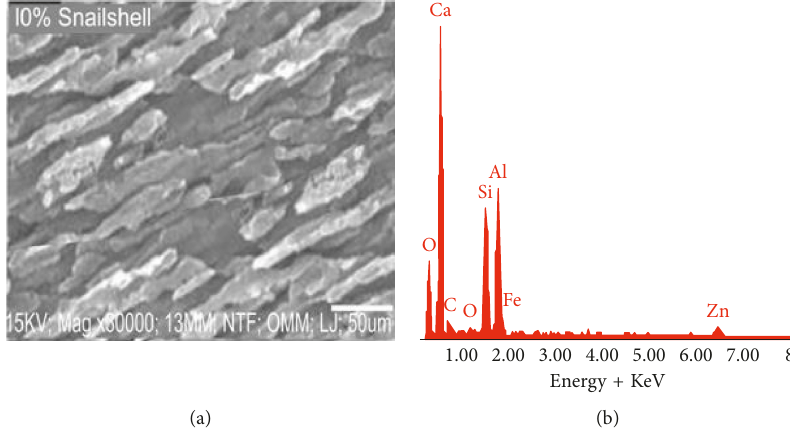
Figure 12: (a) SEM image of AA6061+10 wt% snail shells; (b) EDS of AA6061+10 wt%.